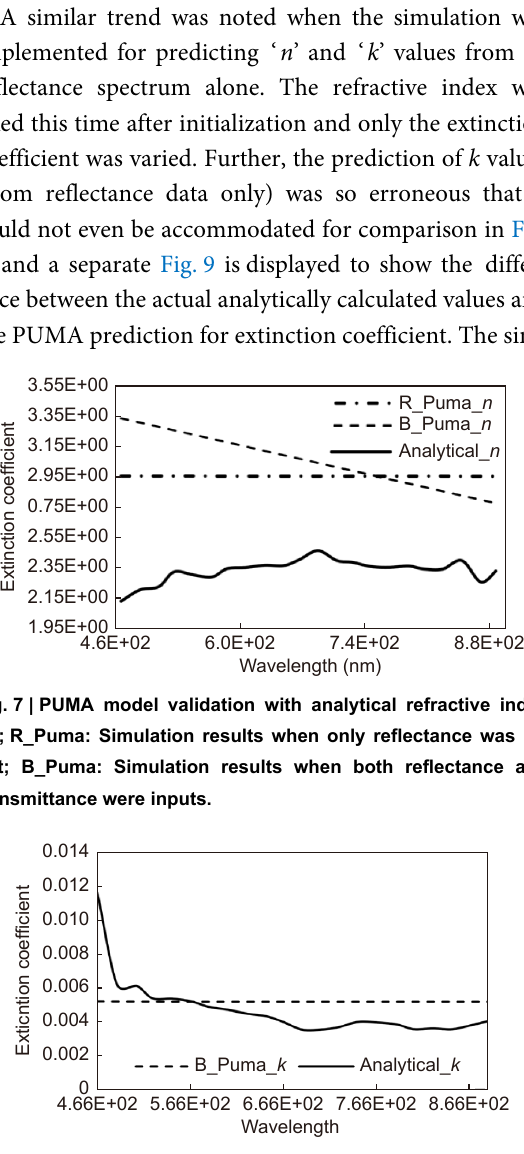
Fig. 8 | PUMA model validation with analytical extinction coeffi- cient ( k ).